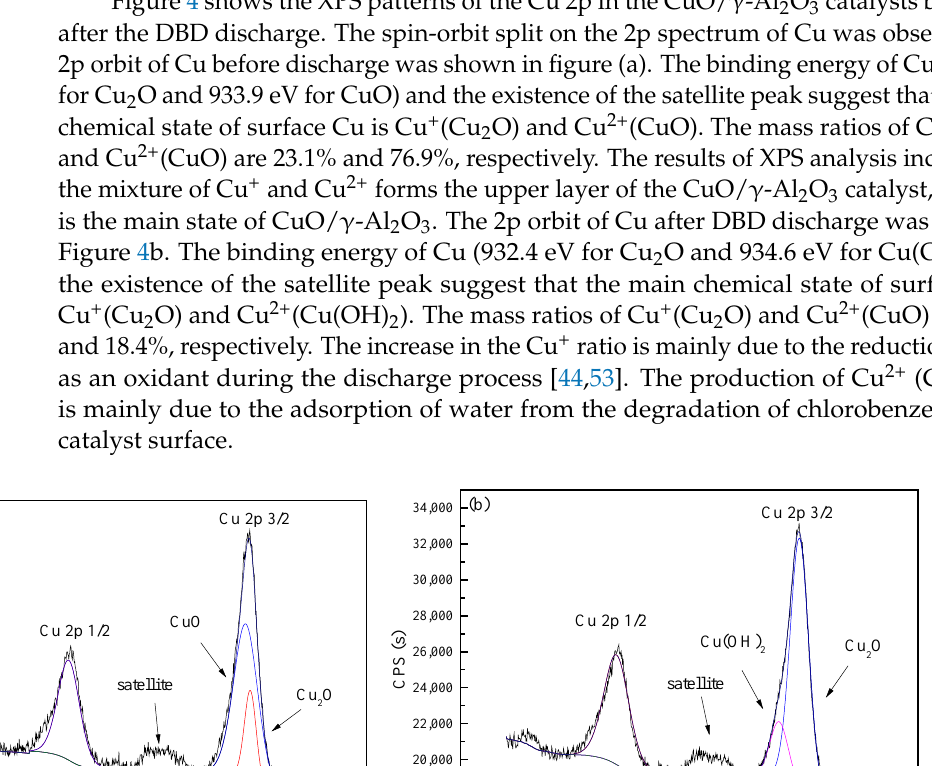
Figure 3. XRD patterns of the CuO/γ -Al 2 O 3 catalysts and the γ -Al 2 O 3 powder.